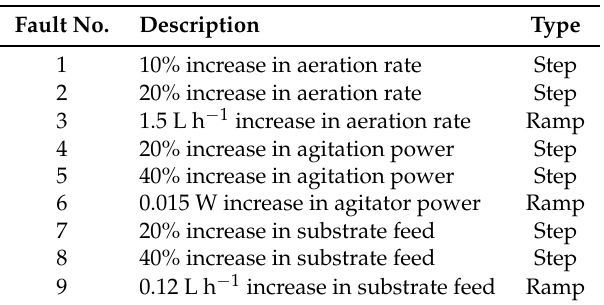
Table 6. Faults simulated by